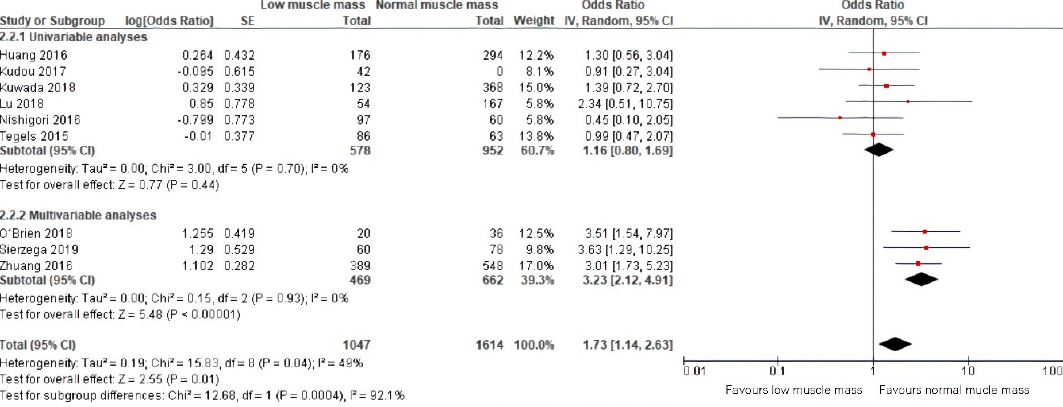
Figure 4. Forest plots of univariable and multivariable odds ratios for severe postoperative complications for gastric cancer patients with low muscle mass versus normal muscle mass.